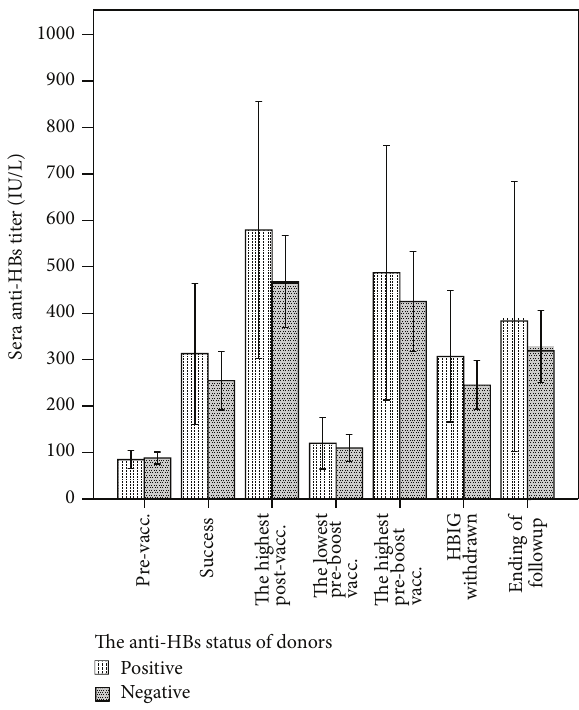
Figure 4: There were no significant differences between the anti- HBs positive and negative donor groups in titer at successful establishment of immunity, the highest titer after vaccination, the lowest titer before booster vaccination, the highest titer after booster vaccination,titerwhenHBIGwaswithdrawn,andthetiterattheend of followup (vacc.: